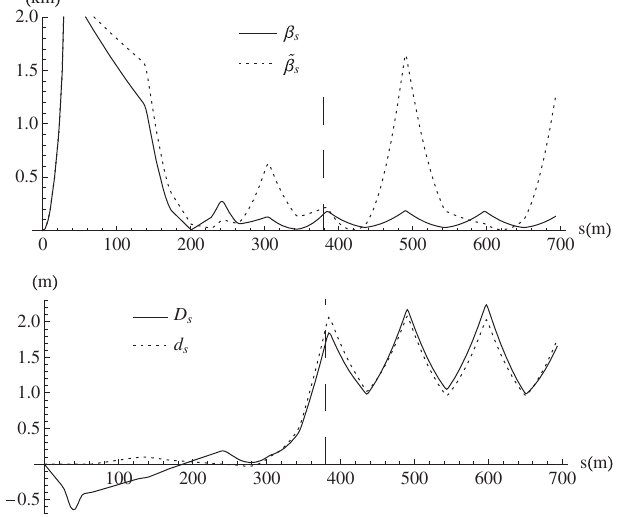
, where D is the periodic on-momentum 1 dispersion. Differences come both from the fact that the BFPP beam envelope is oscillating with ~ (cid:3) , rather like a mismatched beam at injection, and the chromatic variation of the optical functions.